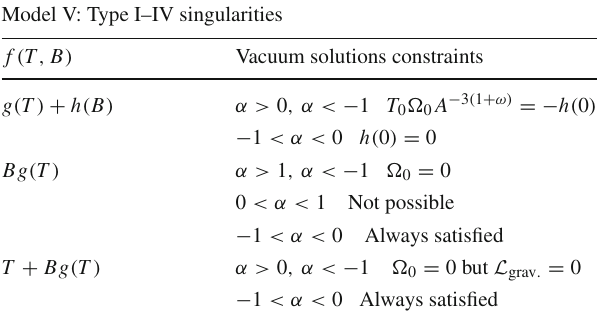
Table 11 A summary of the Lagrangian vacuum constraints for the dif- ferent possible α parameter choices for the scale factor Eq.(44), which yields Type I–IV singularity and Little Rip cosmology scenarios Model V: Type I–IV singularities f ( T , B